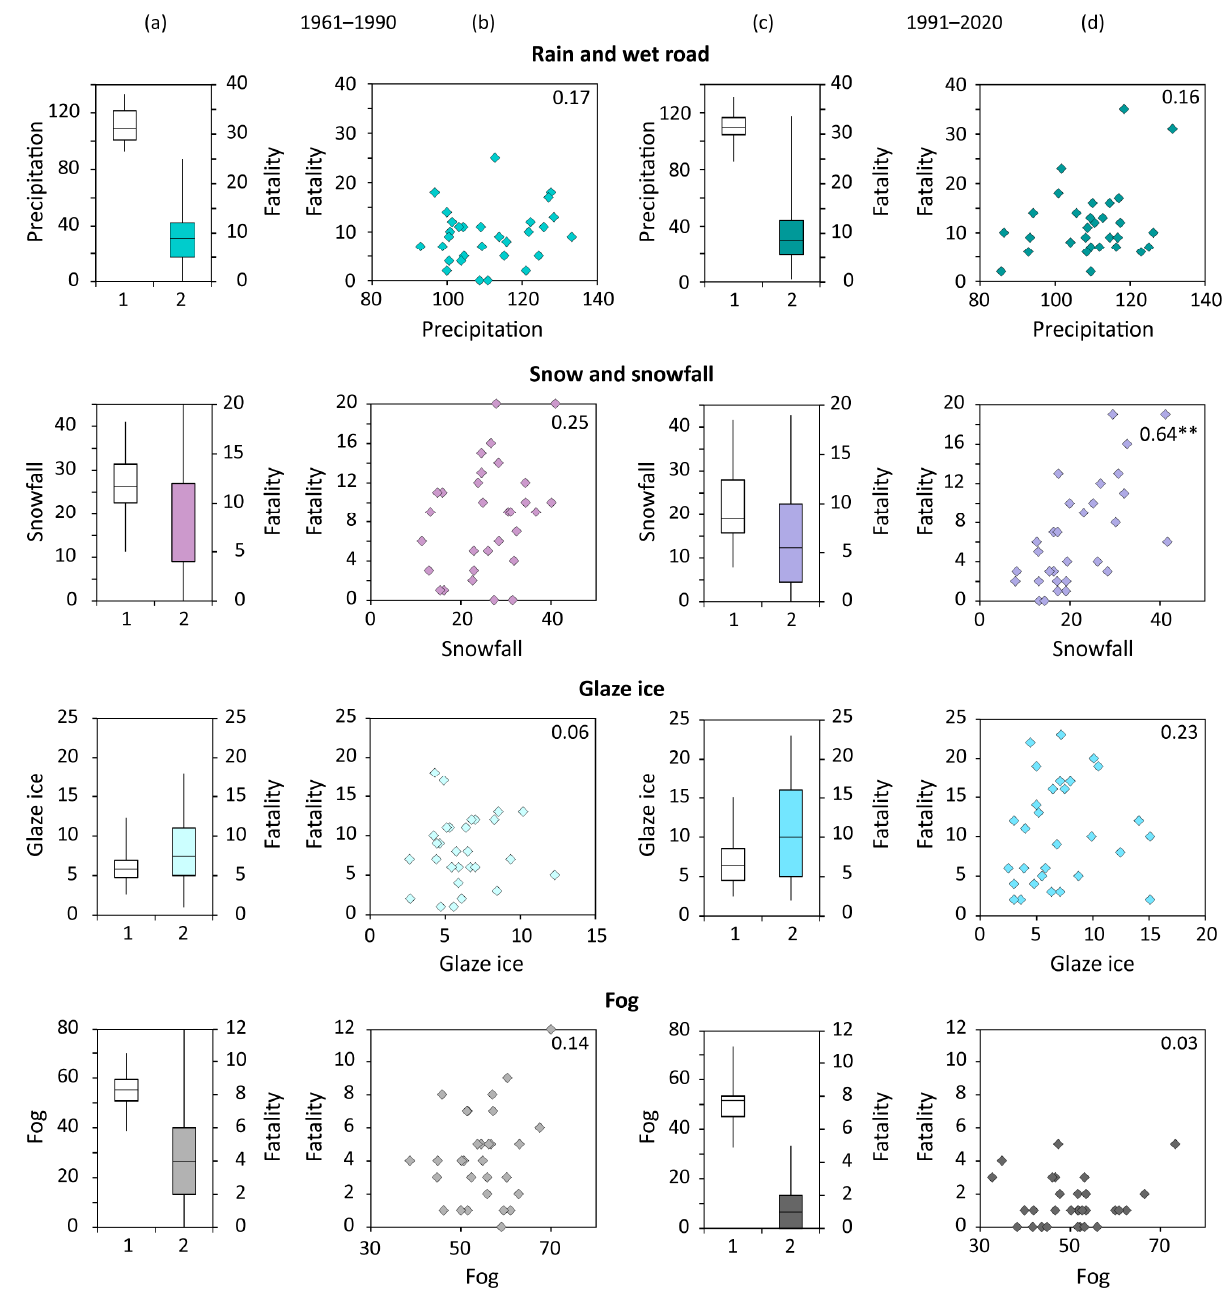
Figure 11. Comparison of selected climate variables (precipitation days with daily total ≥ 1.0 mm, days with snowfall, glaze ice and fog) with related vehicle fatalities (categories rain and wet road, snow and snowfall, glaze ice, fog) in the Czech Republic during the 1961–1990 ( a , b ) and 1991–2020 ( c , d ) periods, expressed as box plots (median, upper and lower quartile, maximum and minimum; 1—climate variable, 2—fatalities) ( a , c ) and scatter-plots between corresponding pairs ( b , d ). Values of Spearman correlation coefficients are in the top right (** significant for p < 0.05).